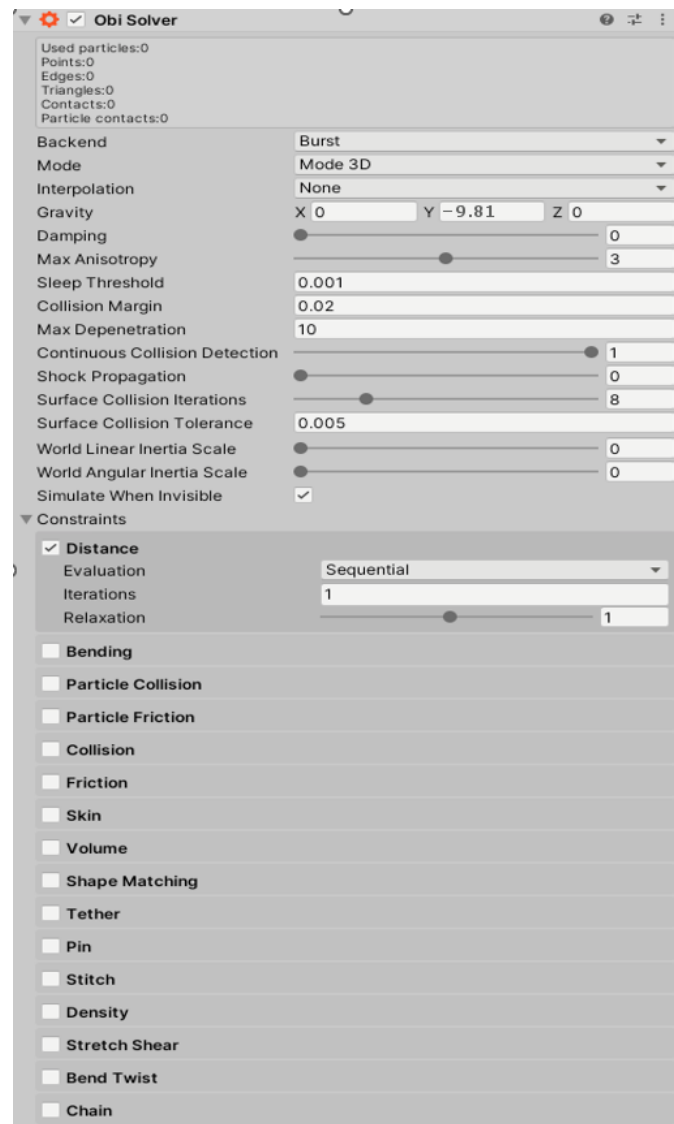
Figure 24. Illustrated operation of the “ Fixed Joint ” component.